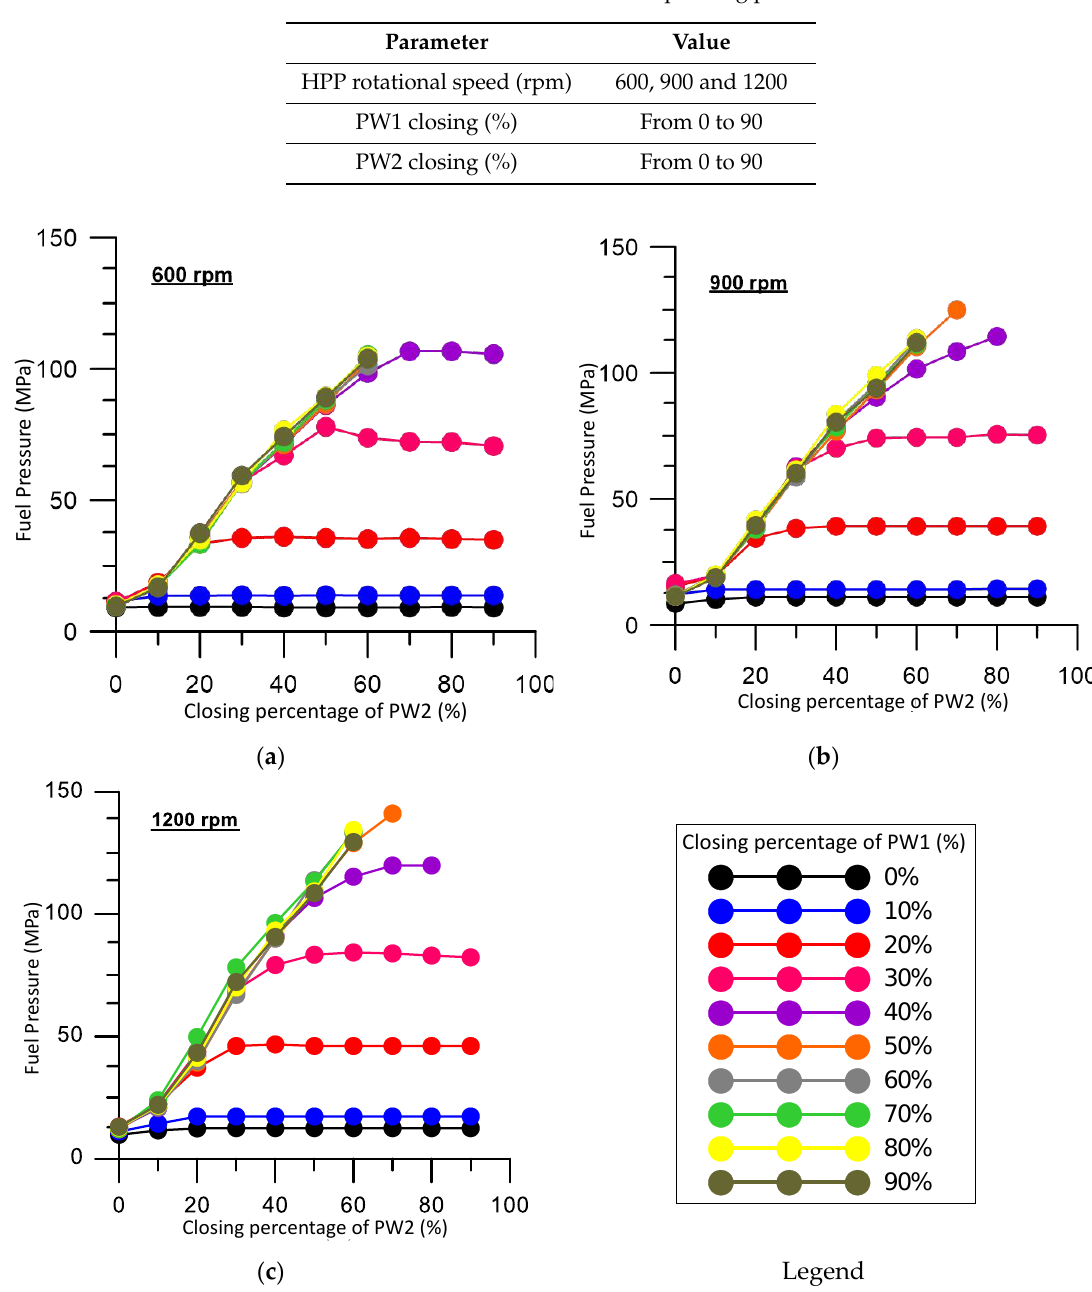
Figure 2. Injection pressure at: ( a ) 600 rpm HPP rotational speed; ( b ) 900 rpm HPP rotational speed; and ( c ) 1200 rpm HPP rotational speed.